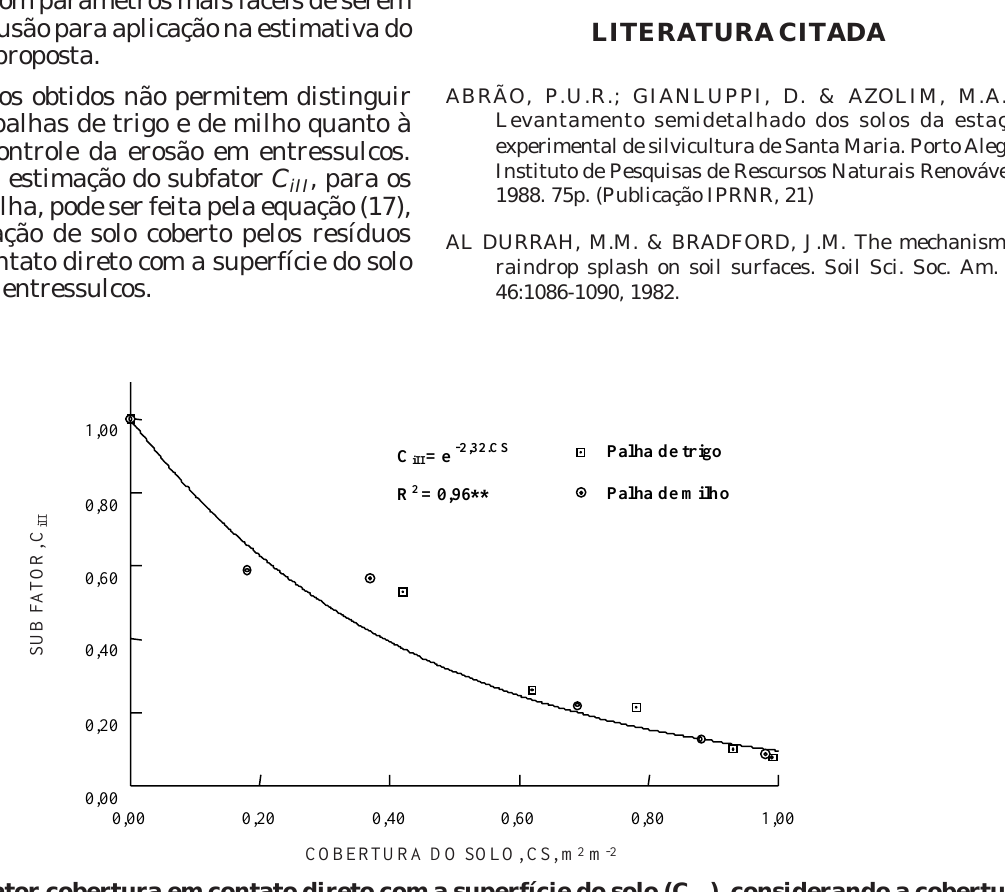
), considerando a cobertura iII